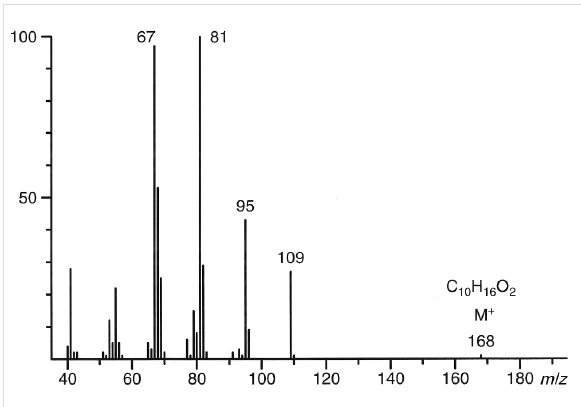
Figure 2: 70 eV EI-mass spectrum of compounds Y and Z of Alloxysta victrix .